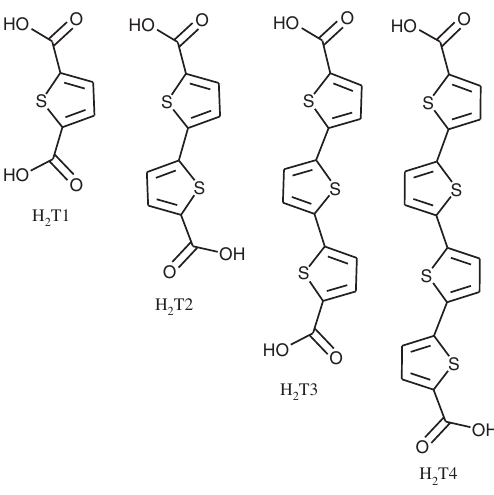
Figure 17: Chemical structure of the oligothiophene acids inserted in the dioate form into layered transition metal hydroxides, H phenedicarboxylic acid, H T2, 2,2 ′ -bithiophene-5,5 ′ -dicarboxylique 2 acid, H T3, 2,2 ′ :5 ′ ,2 ″ -terthiophene-5,5 ″ -dicarboxylic acid and H 2 2,2 ′ :5 ′ ,2 ″ :5 ″ ,2 ′″ -quaterthiophene-5,5 ′″ -dicarboxylic acid.